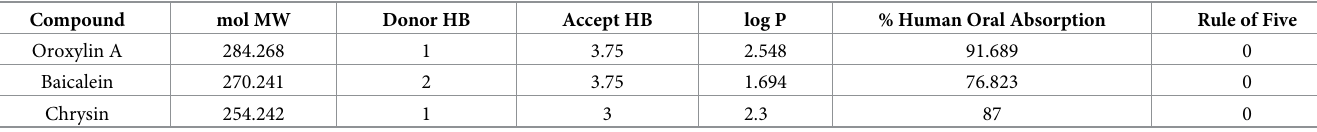
Table 3. Calculated ADME properties of the